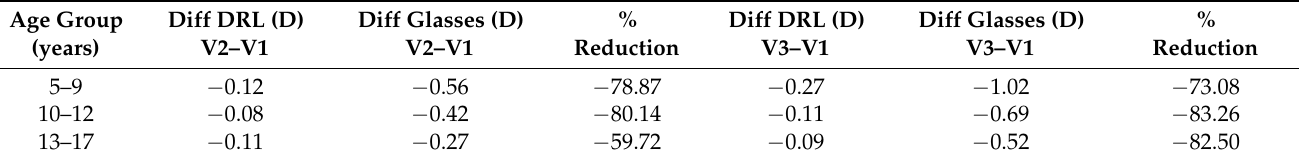
Table 8. Difference values between DRL and glasses treatments as a function of subjects’ age group for the M component of refraction (Comparison at one year and two years from the beginning of